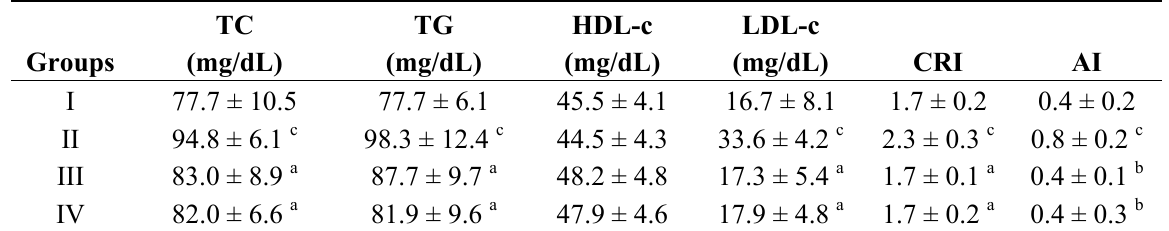
Table 3. Effects of A. capillaris extracts on serum lipoproteins in HFD-induced obese rats.